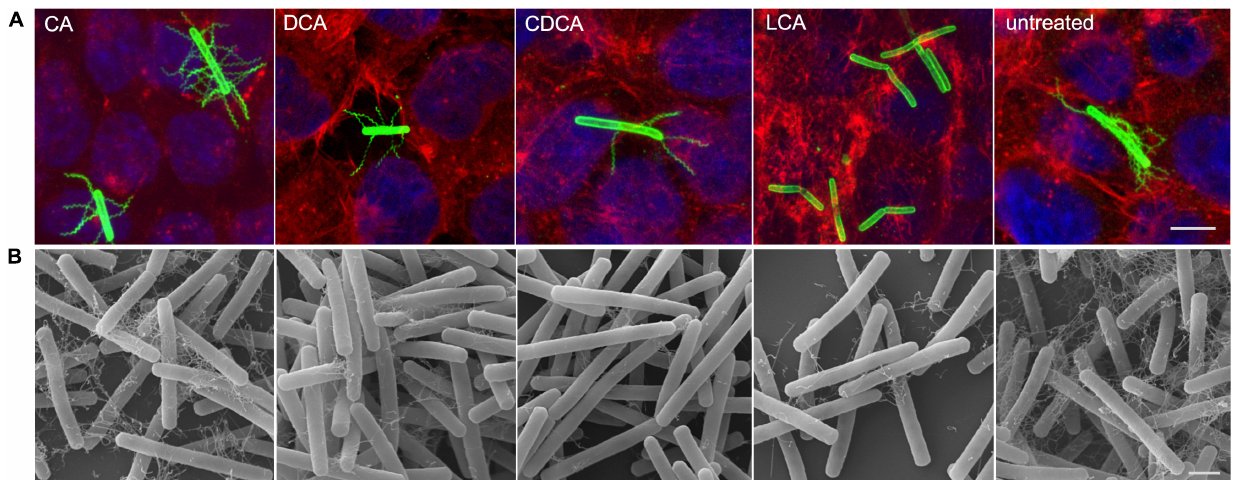
Frontiers in Microbiology |